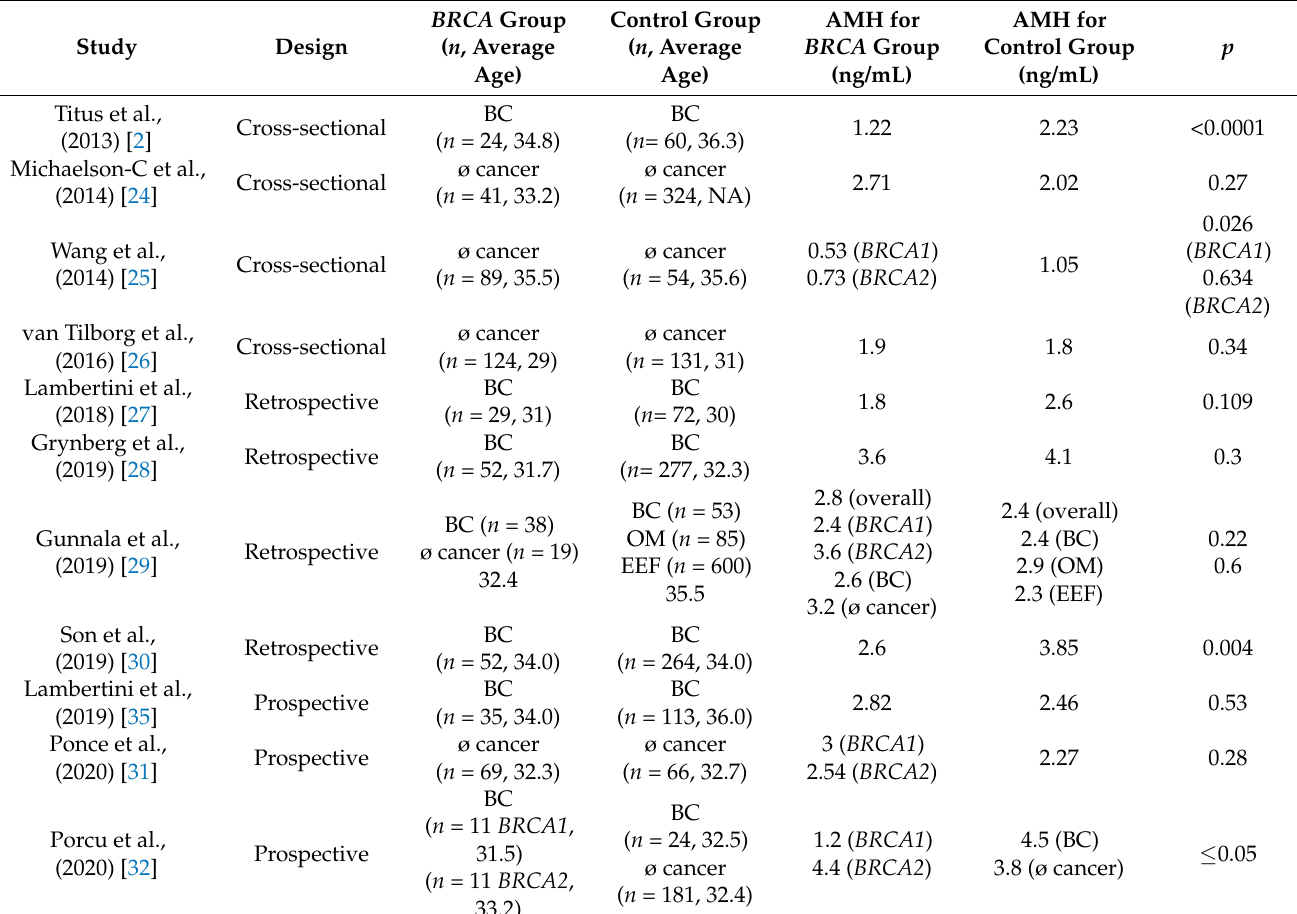
Table 1. Studies assessing anti-Müllerian hormone levels of BRCA pathogenic variant